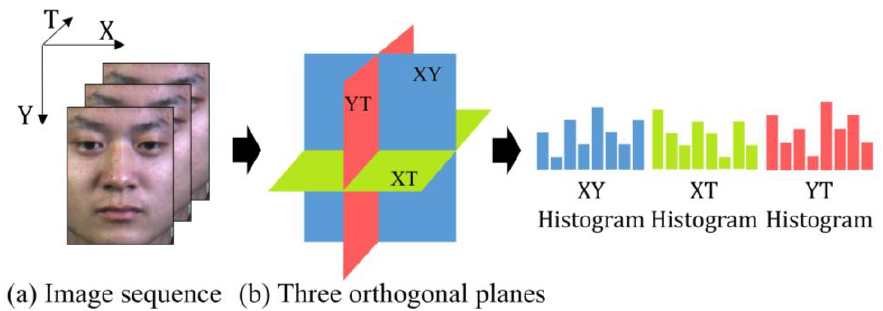
Figure 2. The feature extraction based on three orthogonal planes. ( a ) Three orthogonal directions of the image sequence, ( b ) The illustration of the three orthogonal planes.